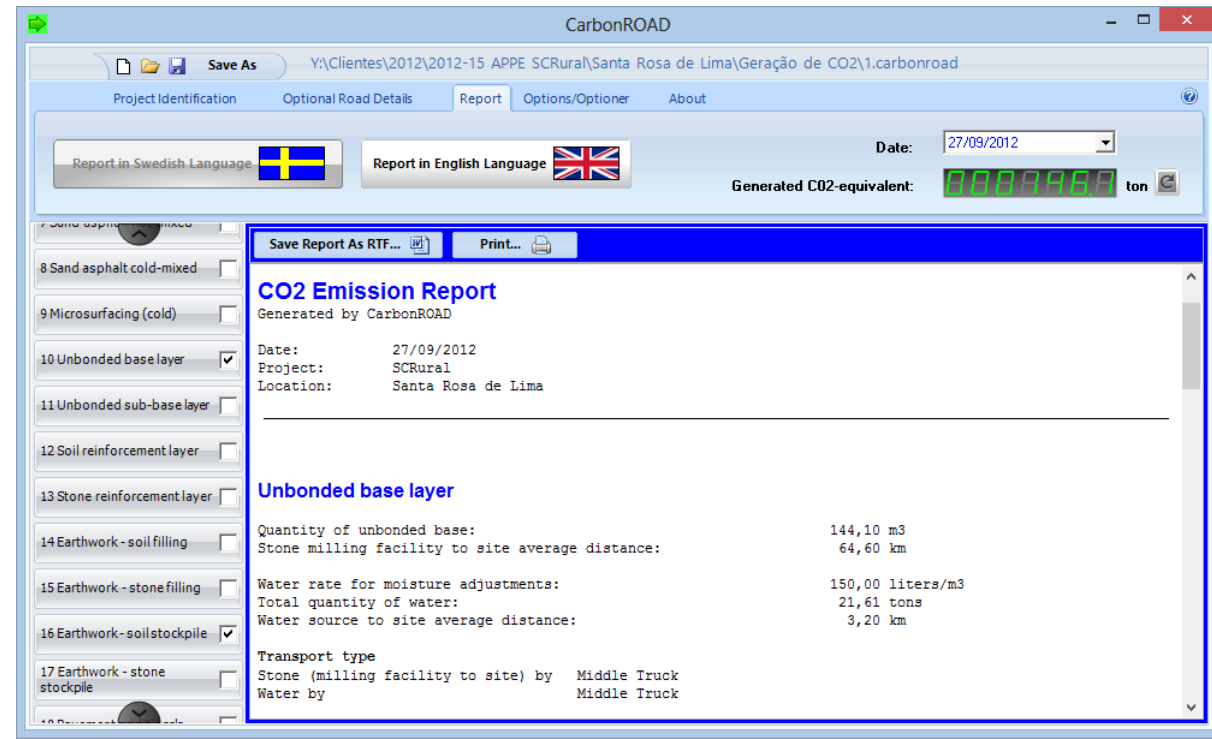
Figure 2. CarbonROAD report.